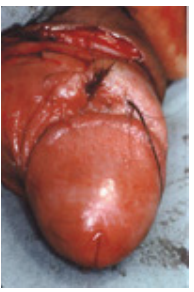
FIGURE 1 . Nests of hair found beneath